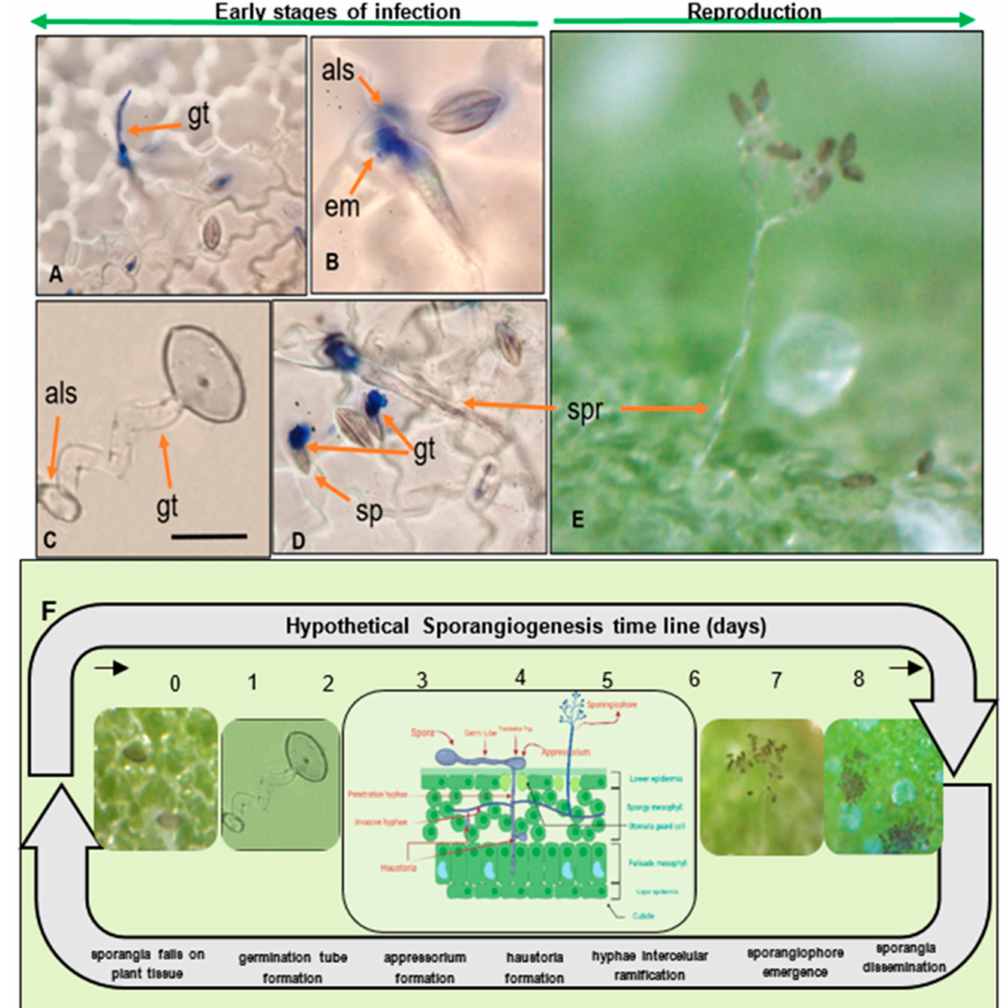
Figure 3. Quinoa leaf infections caused by P. variabilis sporangiogenesis during the early stages of asexual reproduction. ( A ) Sporangium forming germ tube (gt) and faint penetration hyphae towards the mesophyll. ( B ) Extracellular matrices (em) secreted from germinating sporangium (sp) and appressorium-like (als) structure penetrating stomata. ( C ) Sporangium, forming germ-tube (gt) and appressorium like structure in water. ( D ) Sporangiophore (spr) emerging from stomata. ( E ) Sporangiophore holding sporangia, emerging from lower epidermis. Scale bar: 20 µ m. ( F ) Hypothetical P. variabilis sporangiogenesis timeline (Photos: C. Colque-Little). Illustration in timeline created with